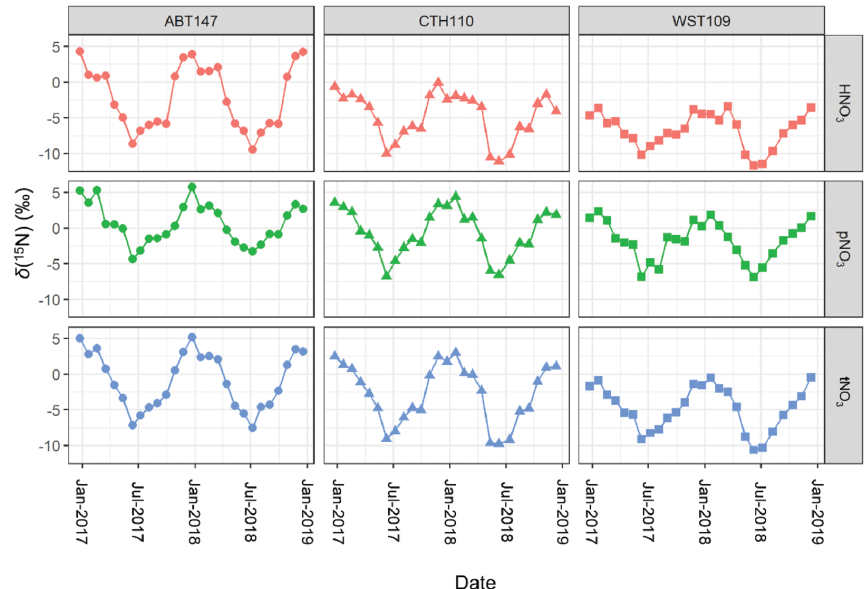
Figure 4. Stable nitrogen isotope ( δ ( 15 N)) composition data of nitric acid (HNO 3 ), particulate nitrate (pNO 3 ), and total nitrate (tNO 3 = HNO 3 + pNO 3 ) at the three CASTNET sites (Connecticut Hill, NY (CTH110); Abington, CT (ABT147); and Woodstock, NH (WST109)) from December 2016 to December 2018.